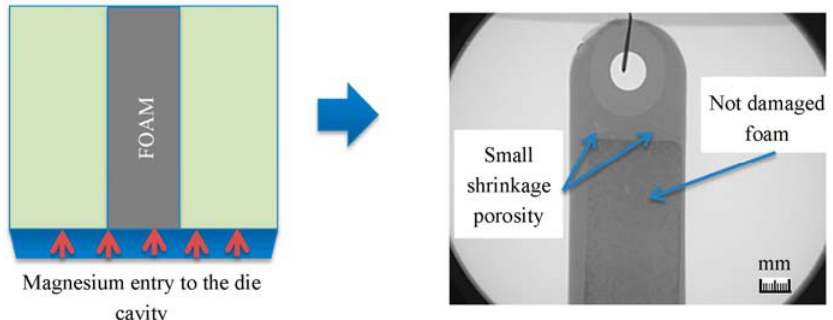
Figure 16. Horizontal core placement to metal flow.